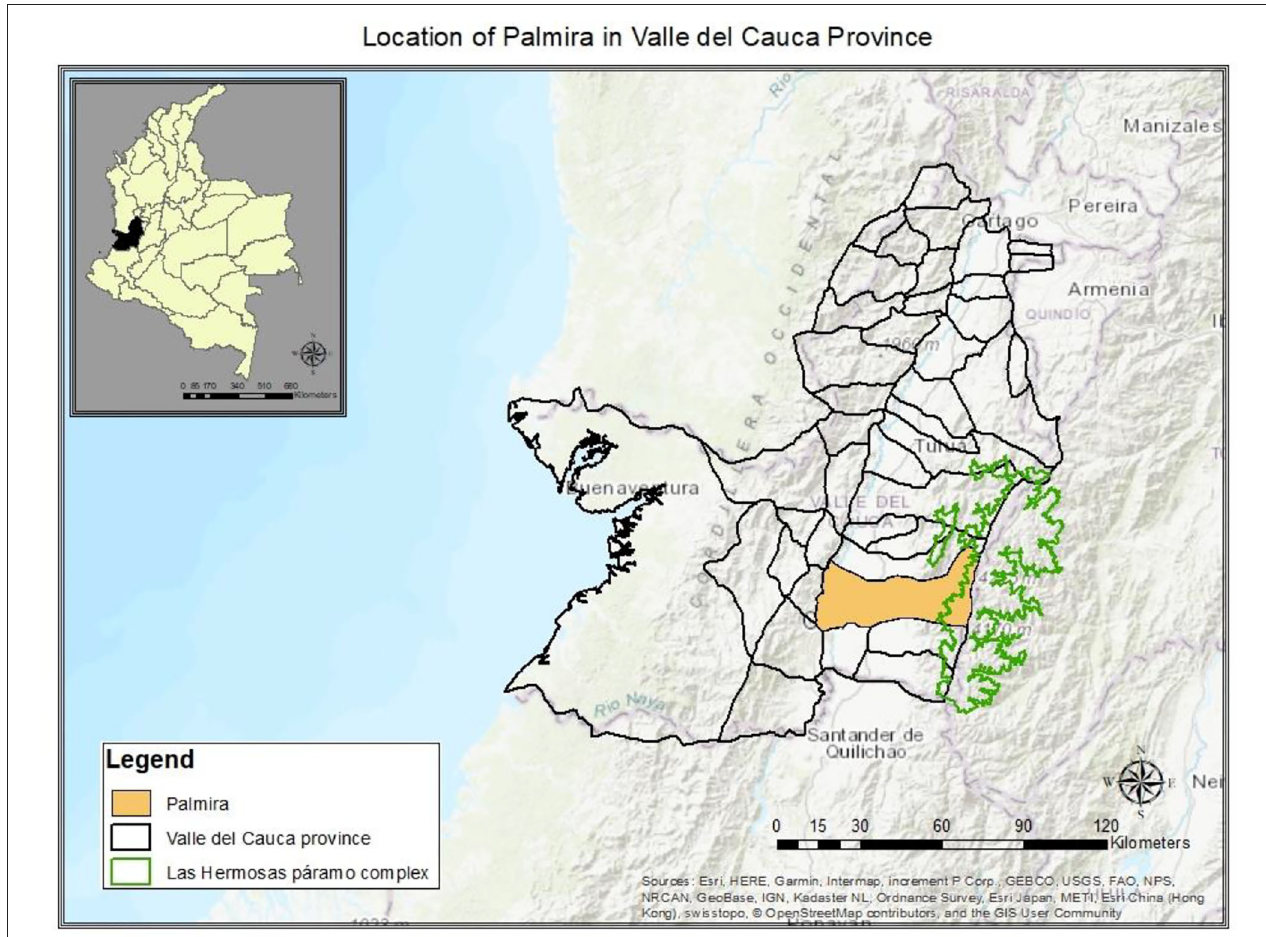
FIGURE 1 | Location of Palmira and Valle del Cauca. Own creation based on cartographic information system Corporación Autónoma Regional del Valle del Cauca (2019)